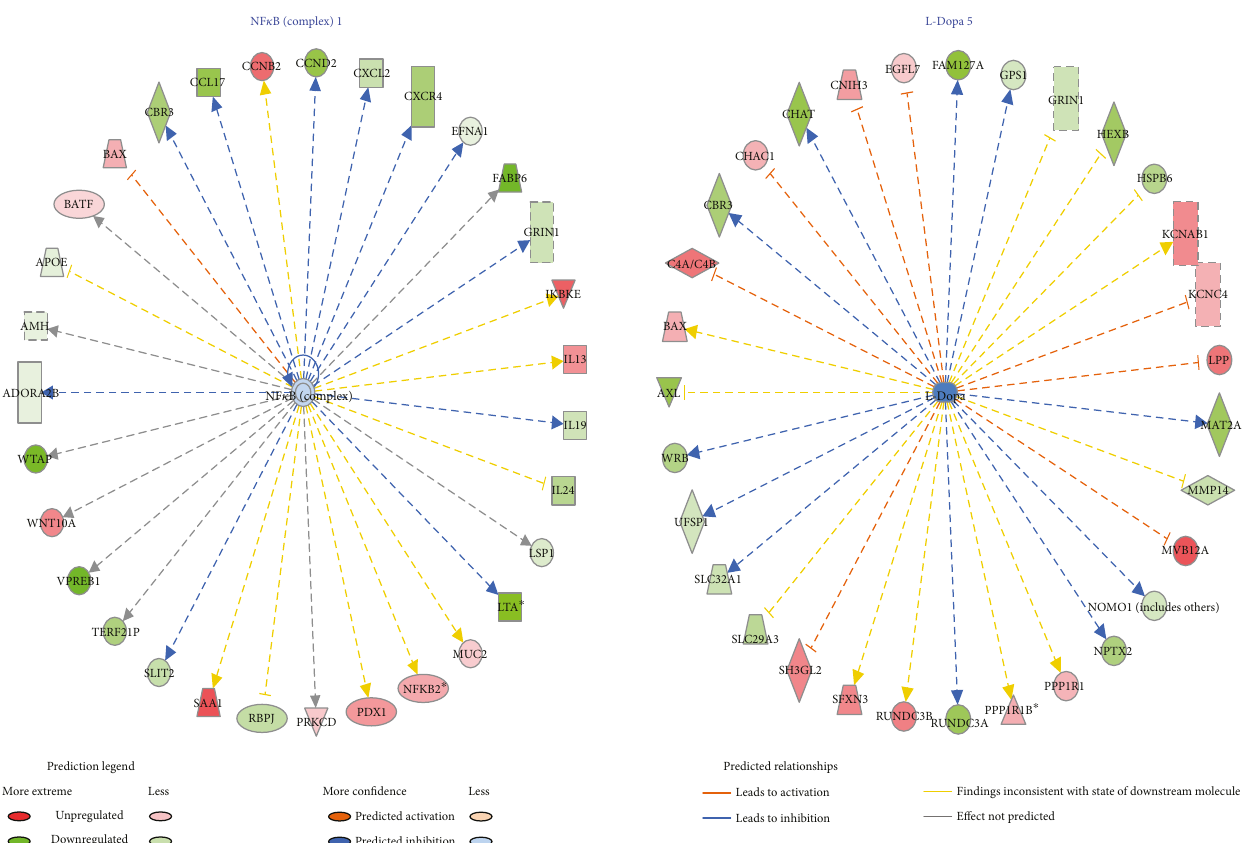
IL24IL19IL13IKBKEGRIN1FABP6EFNA1CXCR4CXCL2CCND2CCNB2 Figure 5: NF κ B complex 1 and L-dopa 5 identi fi ed as upstream regulators with predicted inhibition. This fi gure represents the two upstream regulators with predicted signi fi cant di ff erential regulation resulting from citalopram treatment based on the methylation states (hypermethylated or hypomethylated) of their downstream targets by ingenuity pathway upstream regulator analysis. NF κ B complex 1 is a transcription factor predicted with a higher degree of inhibition (green) with p value =1.79 E − 04. L-Dopa, the initial substrate for neurotransmitter dopamine, is also predicted to be inhibited (green) at a lower degree with p value =1.22 E − 03. With upstream regulators NF κ B complex 1 and L-dopa at the center, the dotted lines with arrow indicate downstream target genes that are upregulated (red) or downregulated (green) due to di ff erential methylation as indicated in our dataset. A dashed line means indirect interaction, continuous line means direct interaction, line with arrow means “ acts on ” and line with bar at the end means “ inhibits. ” These basic relationships between molecules represented in the fi gure are based on literature-reported e ff ects, and the color coding represented in the legend is used for correlation of known relationships with observed gene expression e ff ects resulting from treatment of citalopram. For example, based on literature, L-dopa indirectly acts on SLC32A1, a polyamine transporter. However, in the presence of citalopram, L-dopa bioavailability is decreased, and it is predicted to have an inhibitory e ff ect on SLC32A1 indirectly such that it is